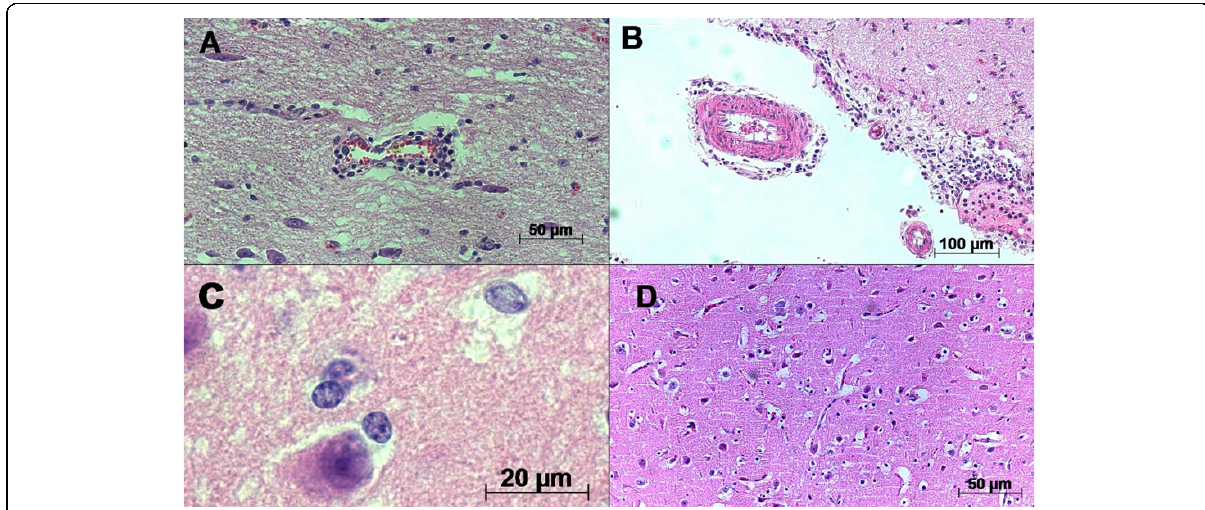
Figure 1 Photomicrography of microscopic aspects of BoHV-5 infected calf brains . A) Inflammatory cuffs composed of mononuclear cells in the parenchyma and B) in the leptomeninges; C) areas presenting inclusion bodies infrequently detected, D) satellitosis and gliosis distributed in the parenchyma and close to neurons. Hematoxylin & Eosin stain; scale bar 50 μ